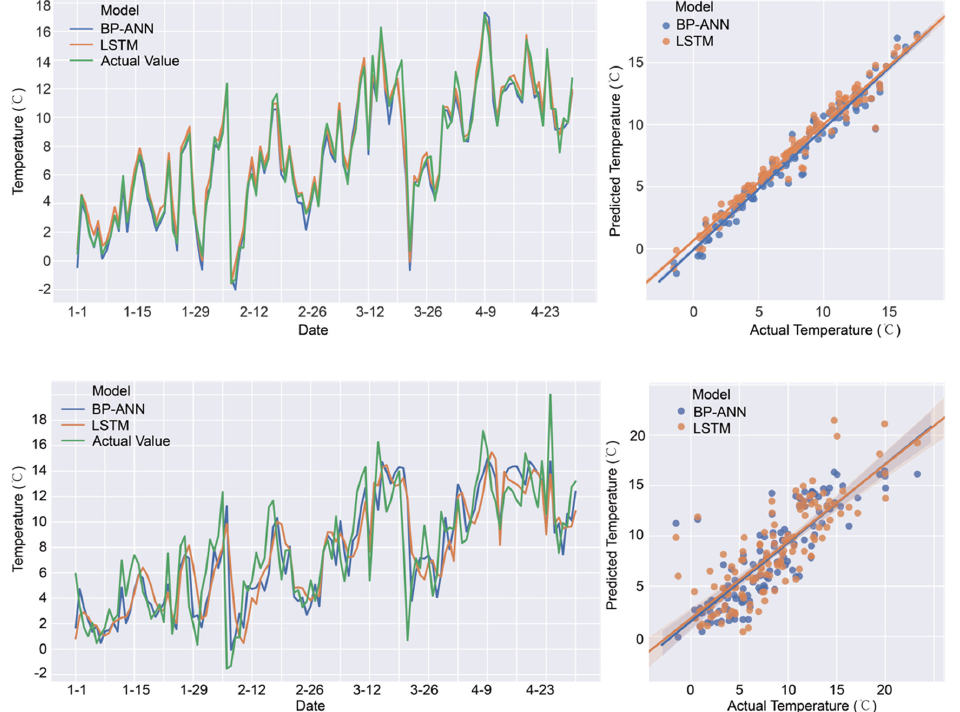
Figure 6. The prediction results of daily minimum temperature using BP-ANN and LSTM tech- niques in Model 1 ( up ) and 2 ( below ).